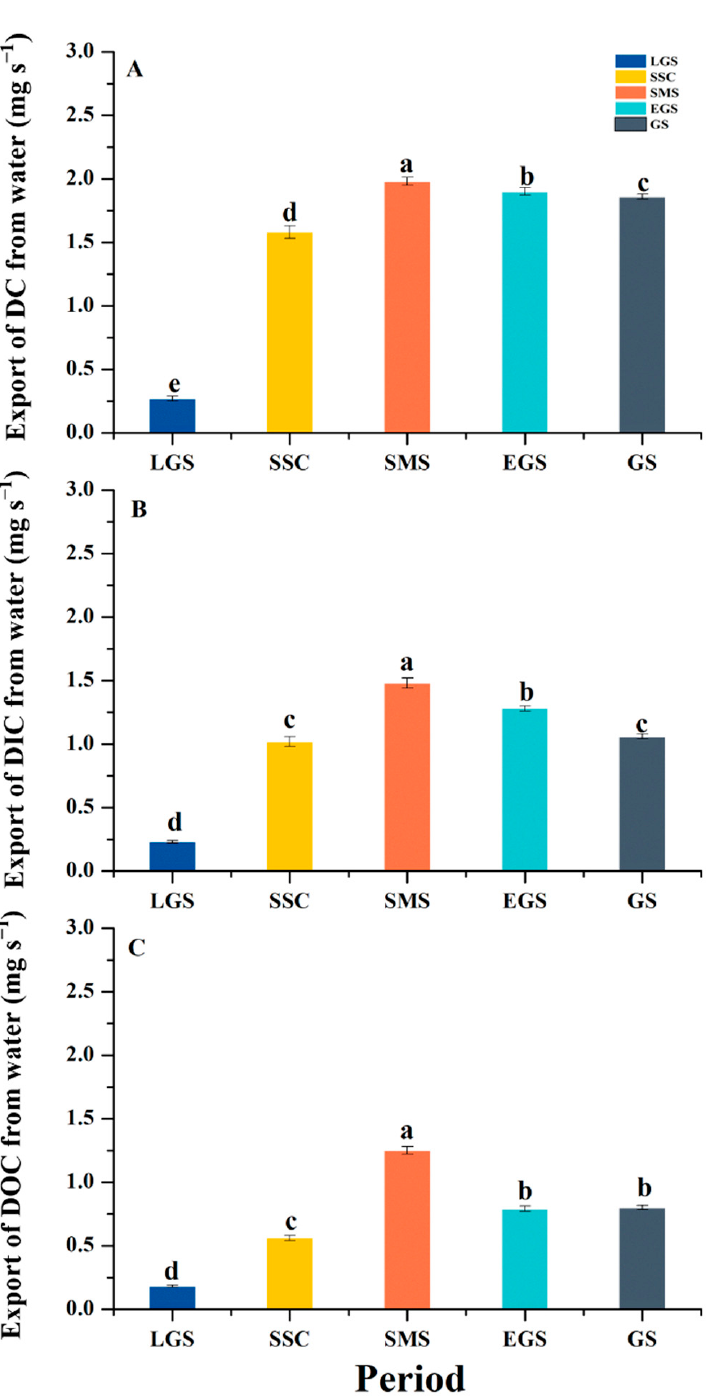
Figure 3. Dynamics of dissolved carbon (DC) export from the subalpine forest streams in the upper reaches of the Yangtze River. Total carbon stock (DC, ( A )); total inorganic carbon stock (DIC, ( B )); total organic carbon stock (DOC, ( C )). LGS, SSC, SMS, EGS, and GS indicate the sampling periods, i.e., the late growing season (LGS: September to October), seasonal snow cover (SSC: November to April of the following year), snowmelt season (SMS: April to May), early growing season (EGS: May to June), and growing season (GS: July to August). The values of the vertical coordinates are the averaged values for 15 streams in this period, and the error bars are the stand deviations of 15 streams during every period. Different lowercase letters indicate significant differences among different periods ( p < 0.05), while the same letter indicates no significant difference among each.